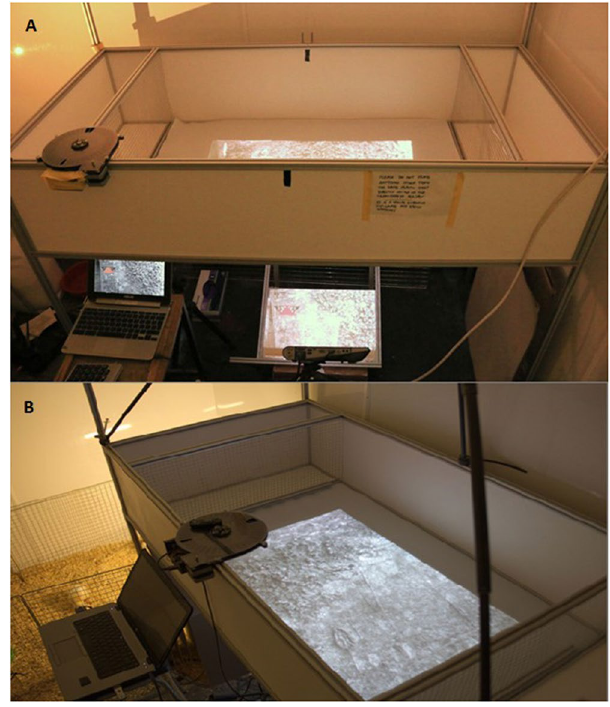
Figure 2. Images of arena showing the projector ( A ) and the layout of the experimental arena in the centre and buddy areas on either side, each containing two buddy chicks ( B